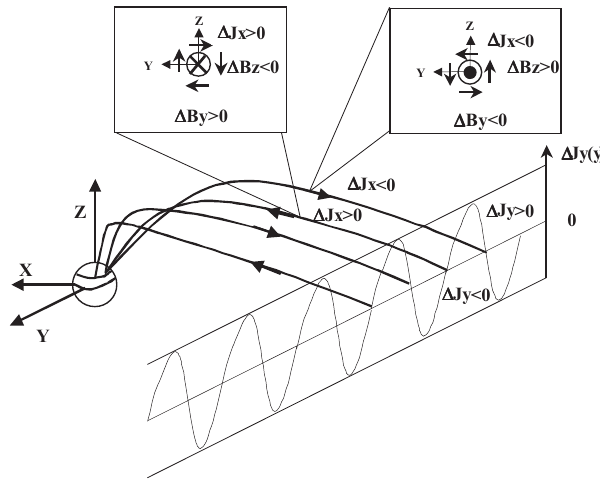
Fig. 5. Schematic view of the parallel current system corresponding to an azimuthal modulation of the cross tail current J y . The top panel inserts display the local magnetic field perturbation produced by a tailward (resp. earthward) parallel current ( ∼ J x